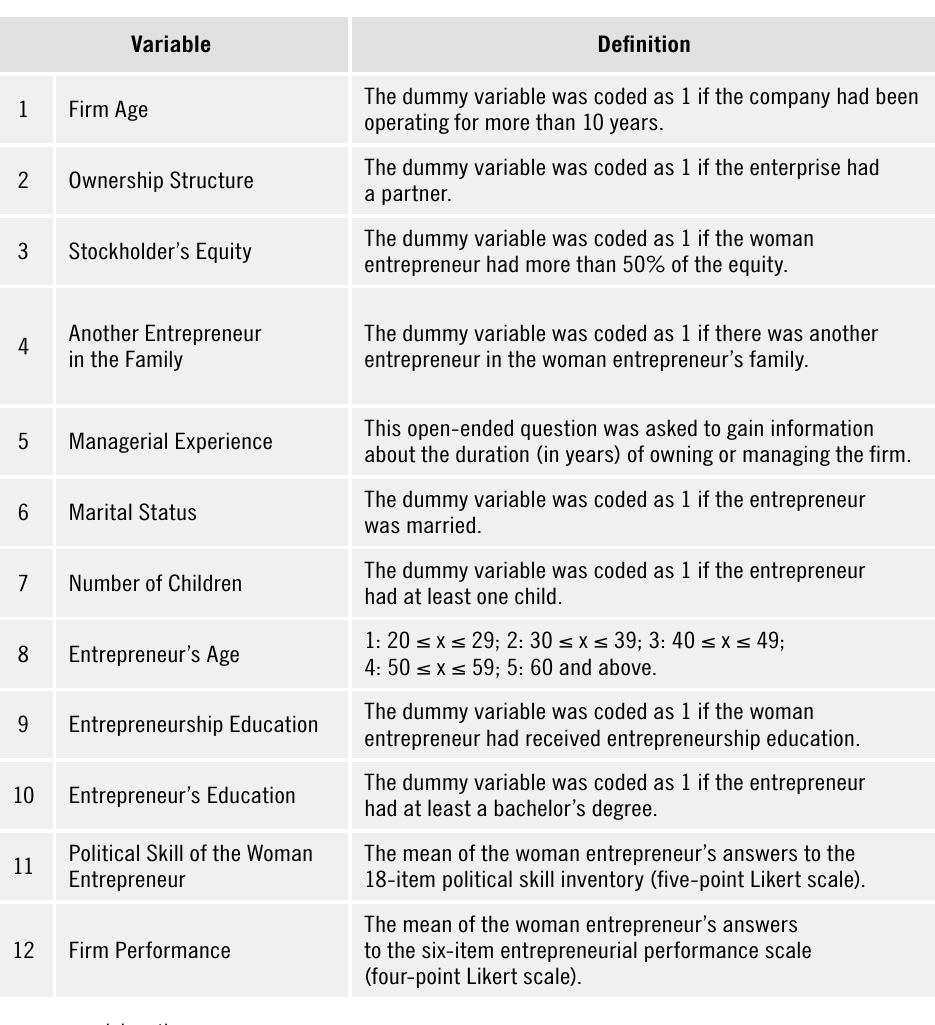
Table 1. Variables and